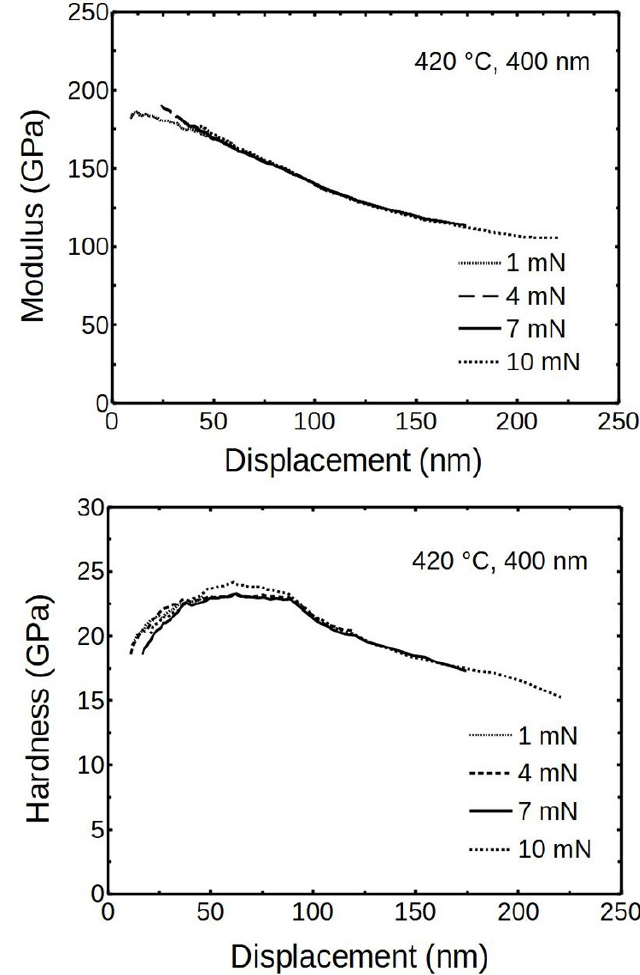
Figure 9. The averaged modulus and hardness of ALD chromia as measured by using different maximum forces.